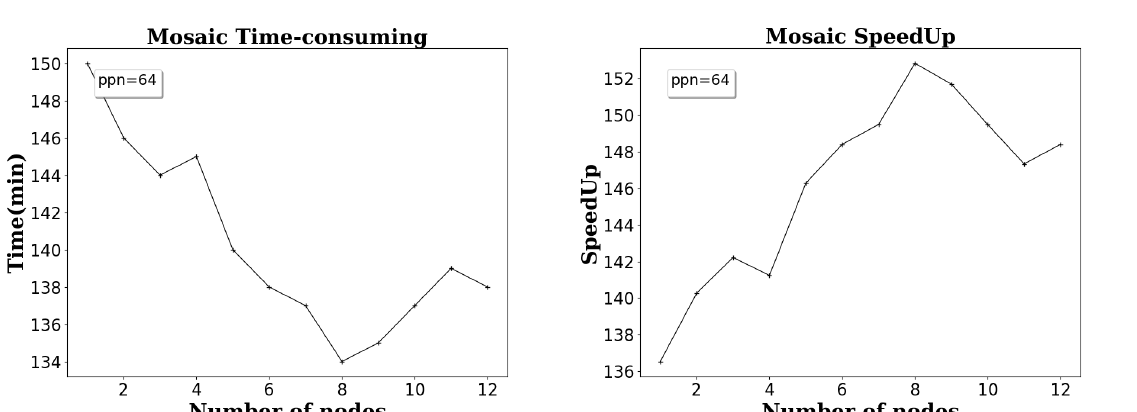
Figure 12. Remote sensing image parallel mosaic experiments were carried out with one to 12 com- puting nodes, of which the PPN was 64. The CPU of a single computing node is 64 cores and the memory is 256